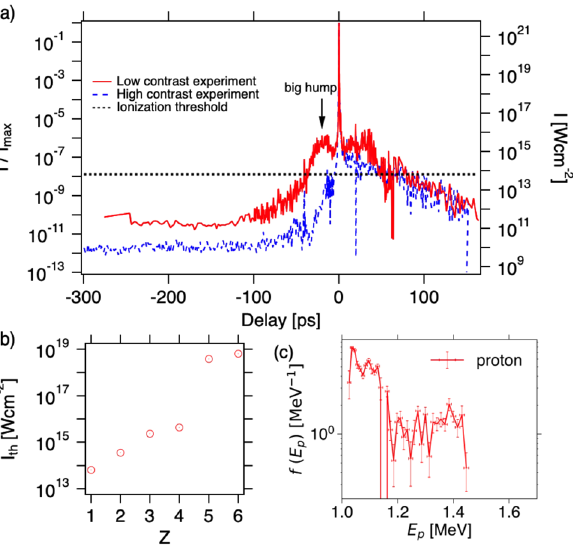
Figure 5. Low contrast shot with double-layer LSG. ( a ) Contrast measurements for low and high contrast experiments. The left and right axes show the normalized and maximum intensity being I max = 5 × 10 21 W cm − 2 , respectively. The horizontal dotted line represents the first ionization threshold of carbon for the field ionization. ( b ) The carbon ionization thresholds for each charge state. ( c ) The proton energy distribution function obtained from TPS with double-layer LSG. The laser energy is 14.8 J corresponding to I = 3.71 × 10 21 W cm − 2 and a 0 = 41.9 .